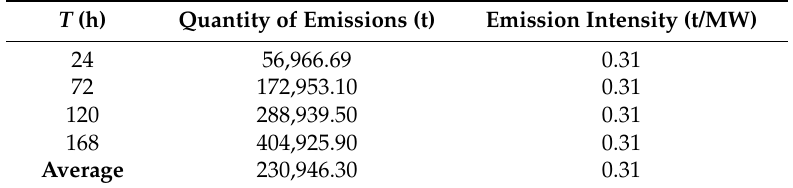
Table 4. The quantity of total emissions and emission intensity under no carbon-tax policy. T